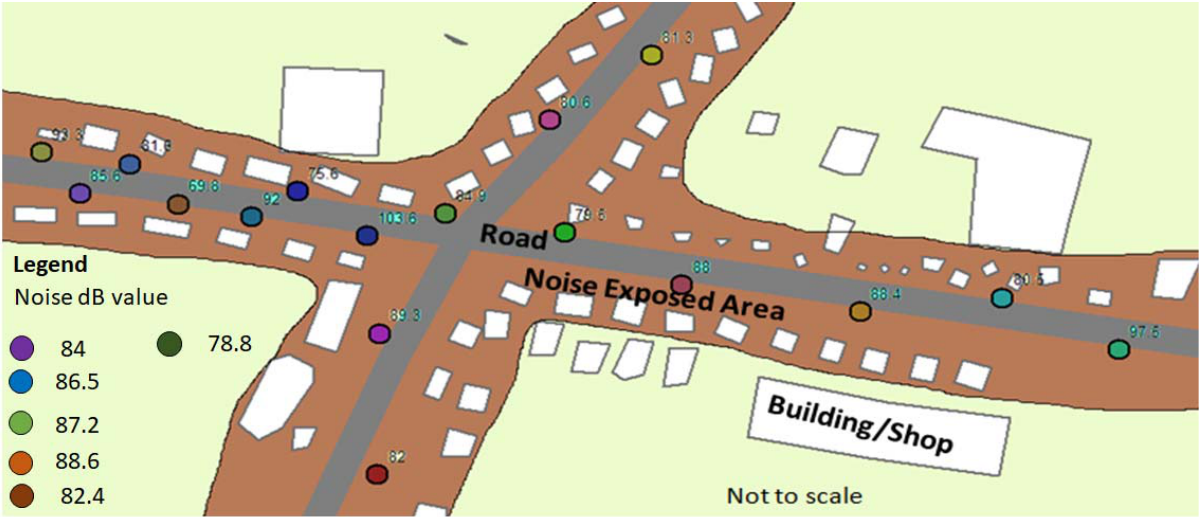
Figure 22. Noise exposures map for short duration at noise value 79.8dB in event wise at time 1–2.30pm.